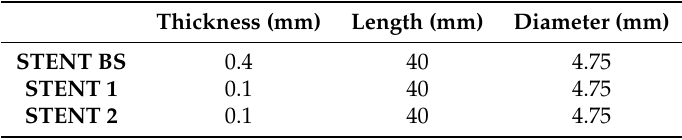
Figure 2. Mesh patterns of the considered FDSs with different porosities (90, 80, and 70%). From the left to the right are STENT BS, STENT 1 and STENT 2. Table 1. Dimensions of the flow diverting stents